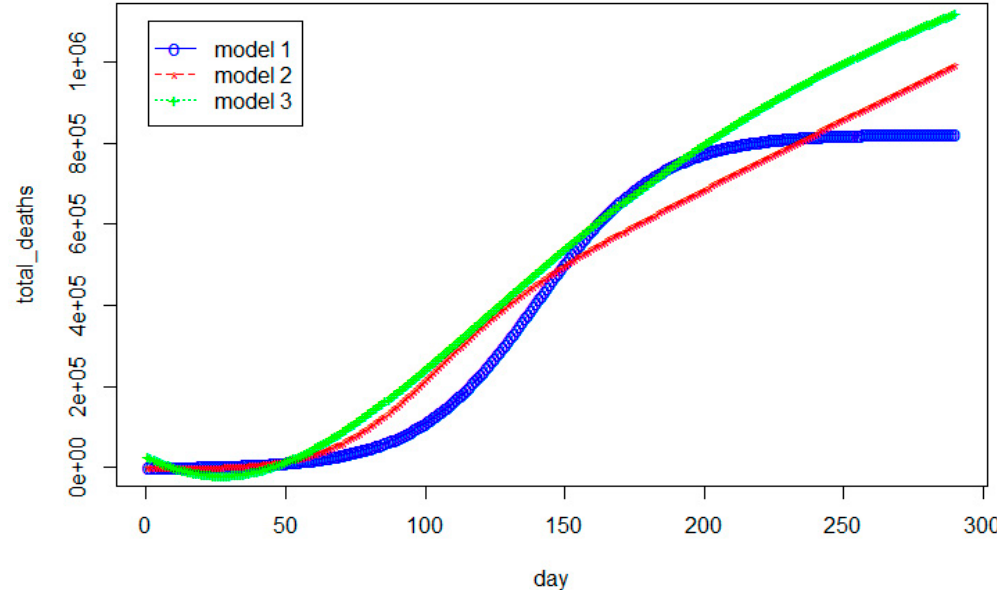
Figure 9. The estimated worldwide cumulative number of deaths over time.